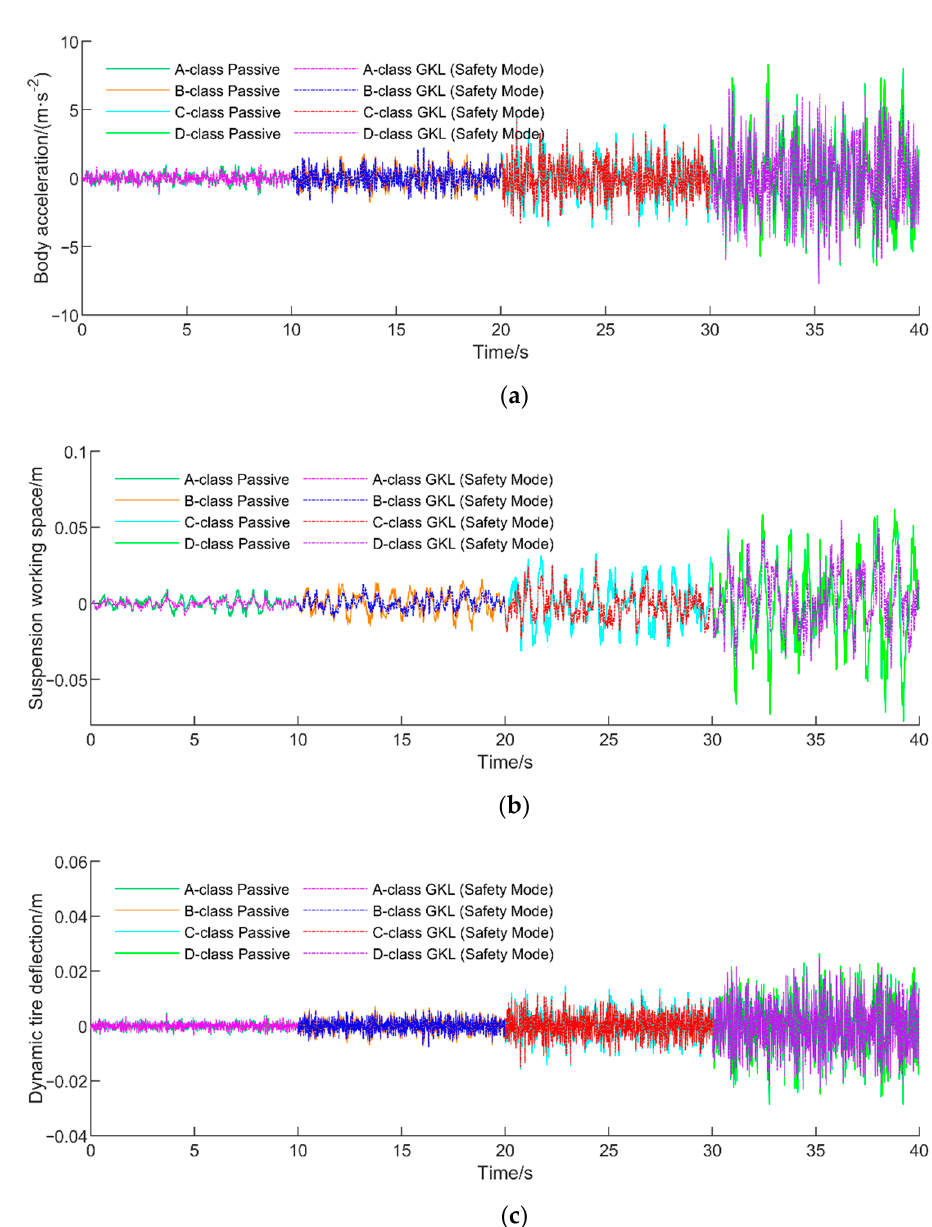
Figure 12. Comparison curves of time domain response for two suspensions (passive suspension and safety mode of active suspension): ( a ) BA; ( b ) SWS; ( c ) DTD.